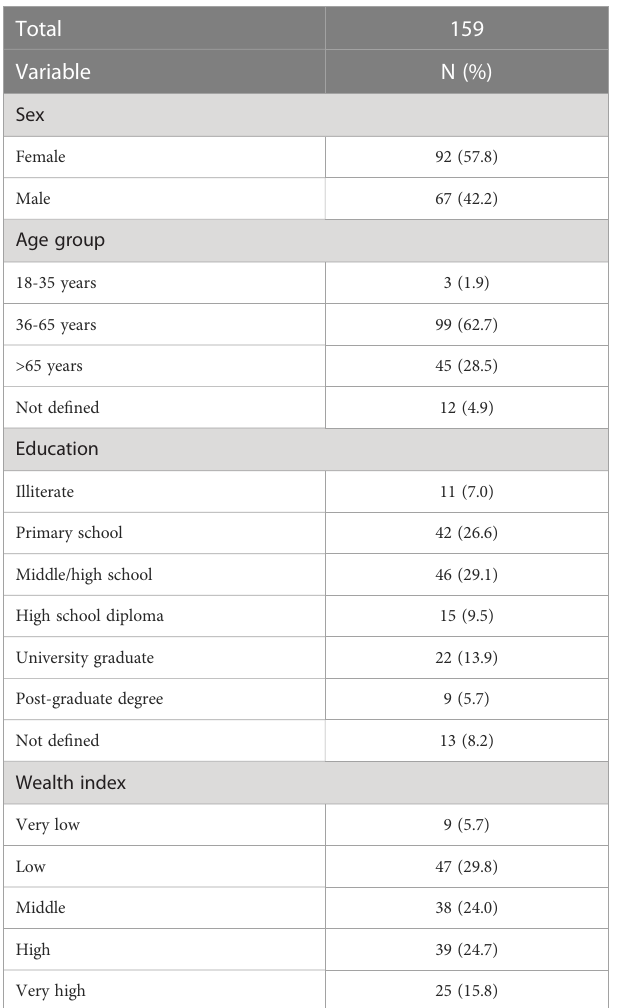
TABLE 1 Sociodemographic characteristics of